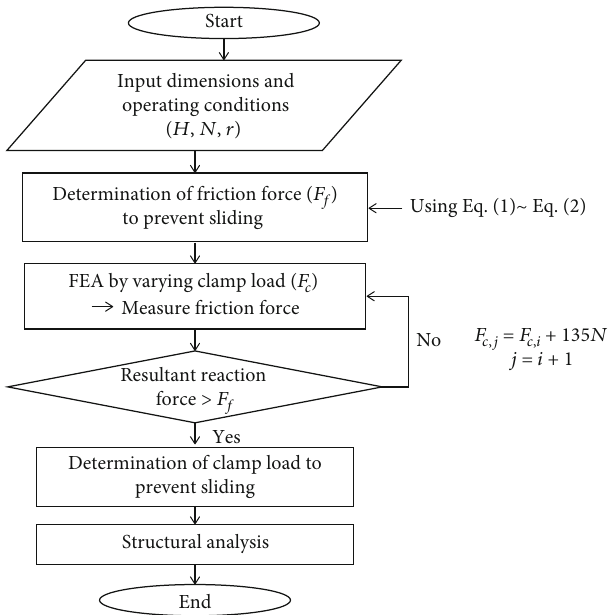
Figure 6: Flow chart for the optimal design of clamp load to prevent sliding between the roller and stud